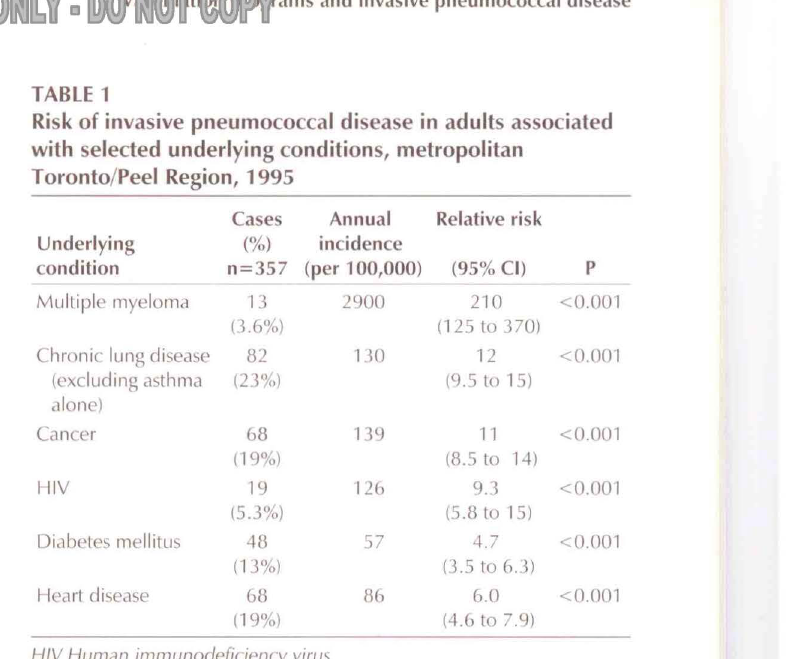
Figure 1) Annual incidenceqfinvasive pnewnococcal disease in Metro politan Toronto and Peel Region. Open bars represent rates in children (younger than I 6years qf age), hatched barsyoungeradults (16 to 64 years qf age) and closed bars older adults (65 years qf age or olde1)